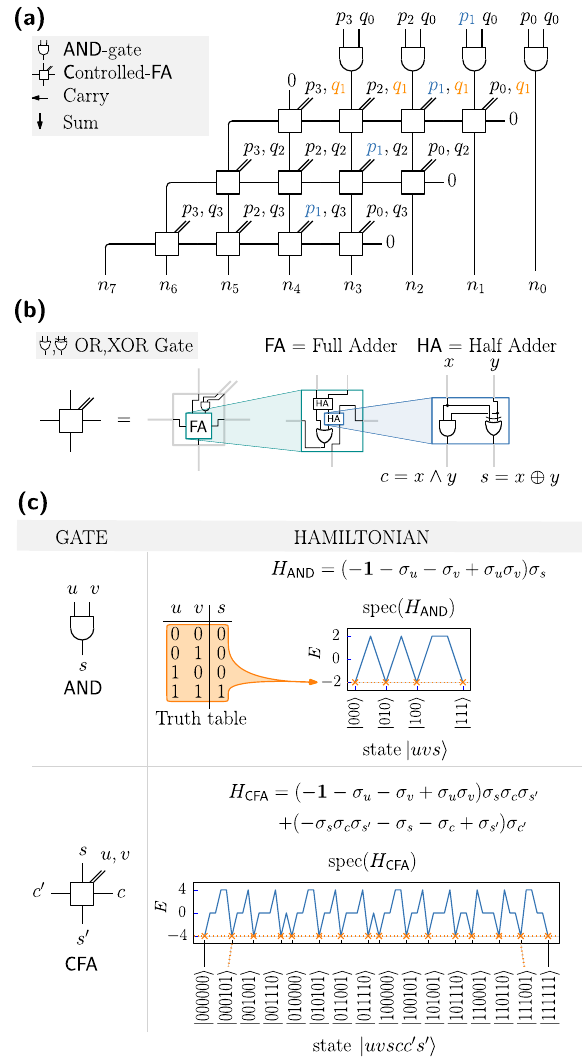
Fig. 2 Boolean multiplier circuit and ground-state-encoding. a Since p i q j = p i ∧ q j , the partial products p i q j can be formed using an AND gate. Subsequently, they can be summed up by full adders arranged on a 2D grid. Note that the gates share common inputs, as the values p i and q j repeat vertically or horizontally, respectively. b Full adders can be built from AND , OR , and XOR gates. c The AND gate can be encoded into the degenerated ground space of a Hamiltonian with four terms. Likewise, the controlled full adder can be encoded by a Hamiltonian consisting of eight terms.